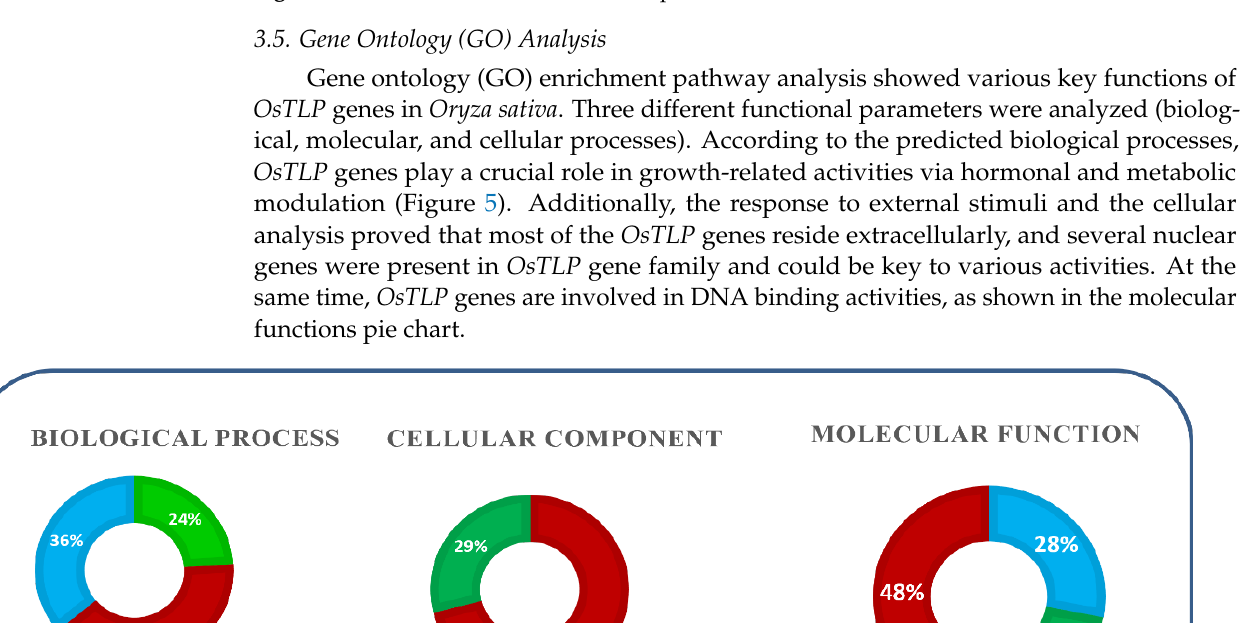
Figure 4. Interactive network of OsTLP1 protein.